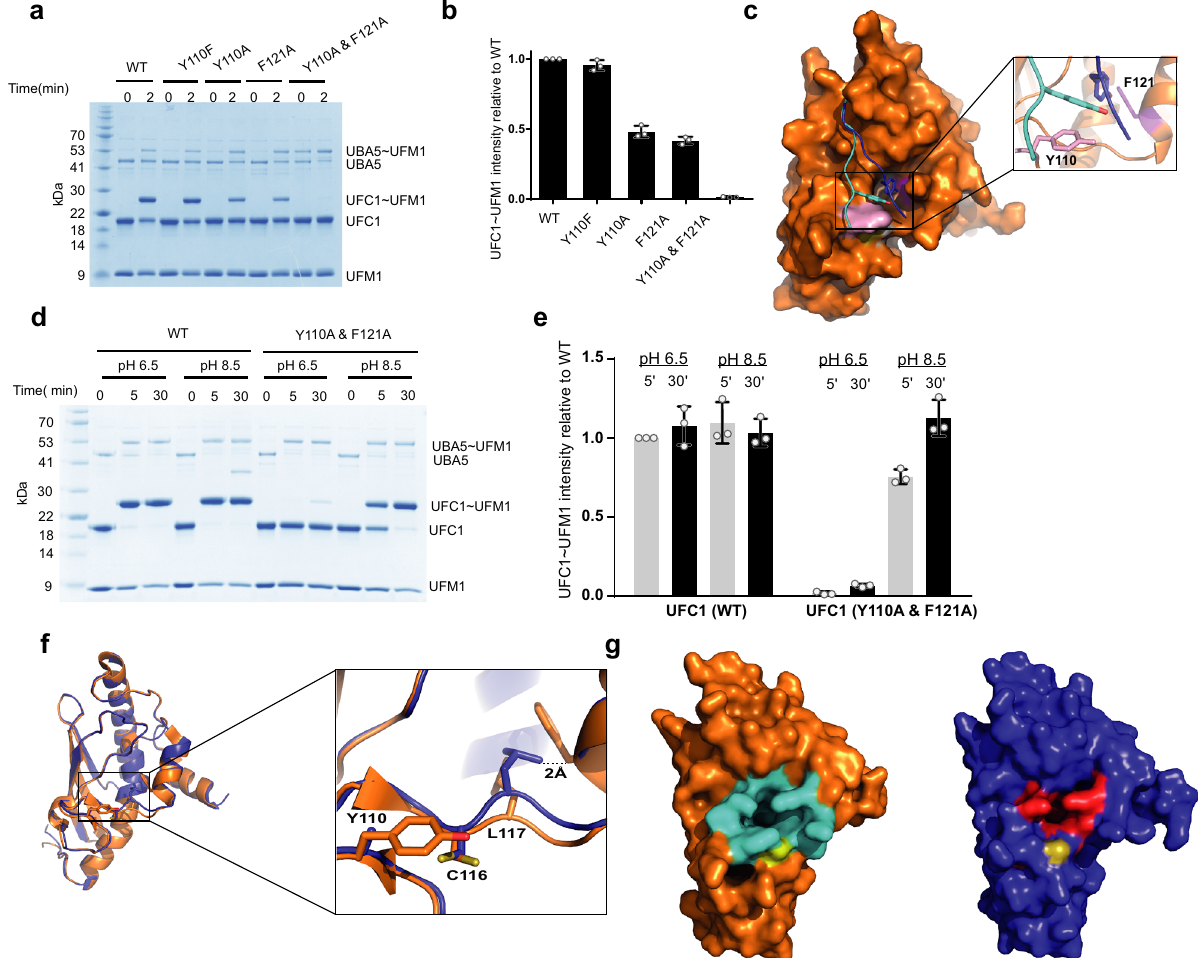
Fig. 5 Aromatic residues are involved in UFC1 desolvation. a SDS – PAGE analysis showing the effect of UFC1 mutations on the transfer of UFM1 to UFC1. b Three independent experiments as shown in A were performed to quantify the effect of the indicated mutations on UFM1 transfer. Data are represented by mean ± SD. c Structural model of the two main conformations (blue and cyan) of UBA5 residues 370-377 bound to UFC1. UBA5 Y372 side chain is shown in stick representation. d SDS – PAGE analysis showing the effect of pH on UFM1 transfer to UFC1 WT or mutant. e Three independent experiments as shown in d were performed to quantify the effect of the indicated mutations on UFM1 transfer. Data are represented by mean ± SD. f Superposition of UFC1 WT (orange) and UFC1 double mutant Y110A and F121A (blue). g Surface representation of UFC1 WT (orange) and double mutant (blue). The UFC1 residues that de fi ne the cavity are colored in cyan and red for WT and double mutant, respectively. Active site Cys is shown in